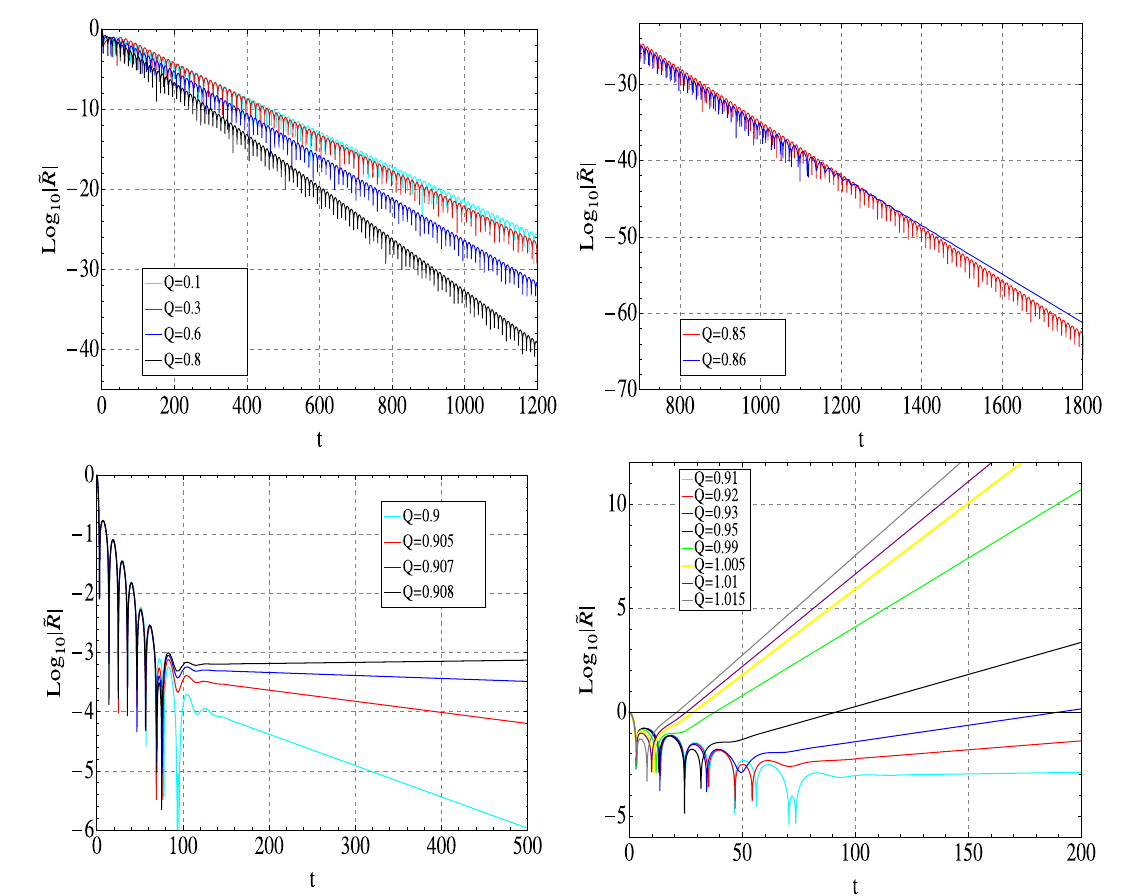
Fig. 4 ScalarfieldpropagationinaRNdSblackholewithnon-minimal coupling with parameters M = L 2 / 36 = (cid:2)/ 2 = η/ 50 = 1, m 2 = 0, resulting in V X > 0 when Q < Q c ∼ 0 . 85. The instabilities in the field arise as a result of the mixed potentials (negative and positive) for large